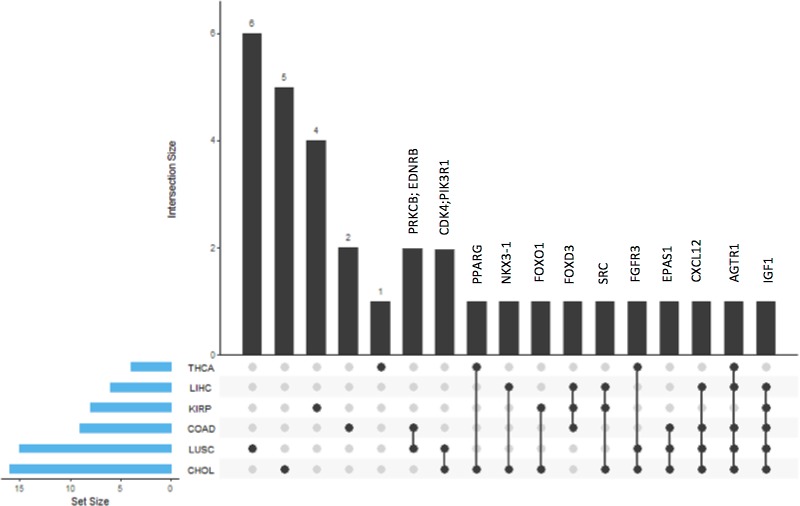
Diagram illustrating the genes shared by different cancers and the cancers among which they are shared.Diagram showing the overlaps of affected oncogenes/tumor suppressors between different cancer types. Black bars are representing the number of genes that are overlapping between different cancers and that are unique to a specific cancer. Gene names for the genes observed in more than single cancer is also shown. Blue bars indicate the total amount of affected oncogenes/tumor suppressors in that specific type of cancer. AGTR1 and IGF1 are observed as affected in 5 different cancer types, improving their significance compared to other oncogenes/tumor suppressors.